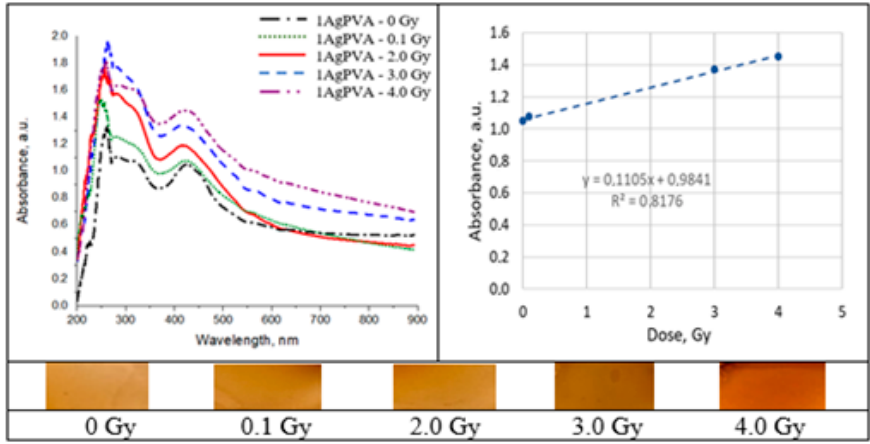
Figure 11. Absorbance and sensitivity of the 6 MeV irradiated AgPVA films.